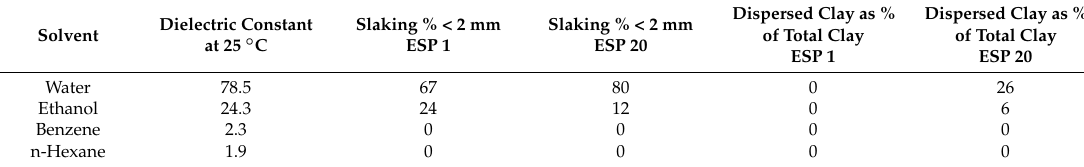
Table 1. Slaking and dispersion of Alfisol aggregates (2–4 mm) at two levels of sodicity in various solvents (after Rengasamy and Sumner [16]). ESP = exchangeable sodium